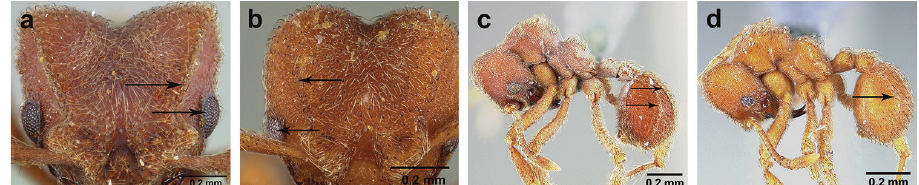
Figure 14. S. scrobifer , S. parvulus , and S. maravalhas. a S. scrobifer head, full-face view, arrows indicate complete frontal carina and large, convex eye b S. parvulus head, full-face view, arrows indicate incomplete frontal carina and small, almost flat eyes c S. maravalhas , lateral view, arrows indicate lateral and dorsal carinae on gaster d S. parvulus , lateral view, arrow indicates lateral carina on gaster, dorsal carina absent.